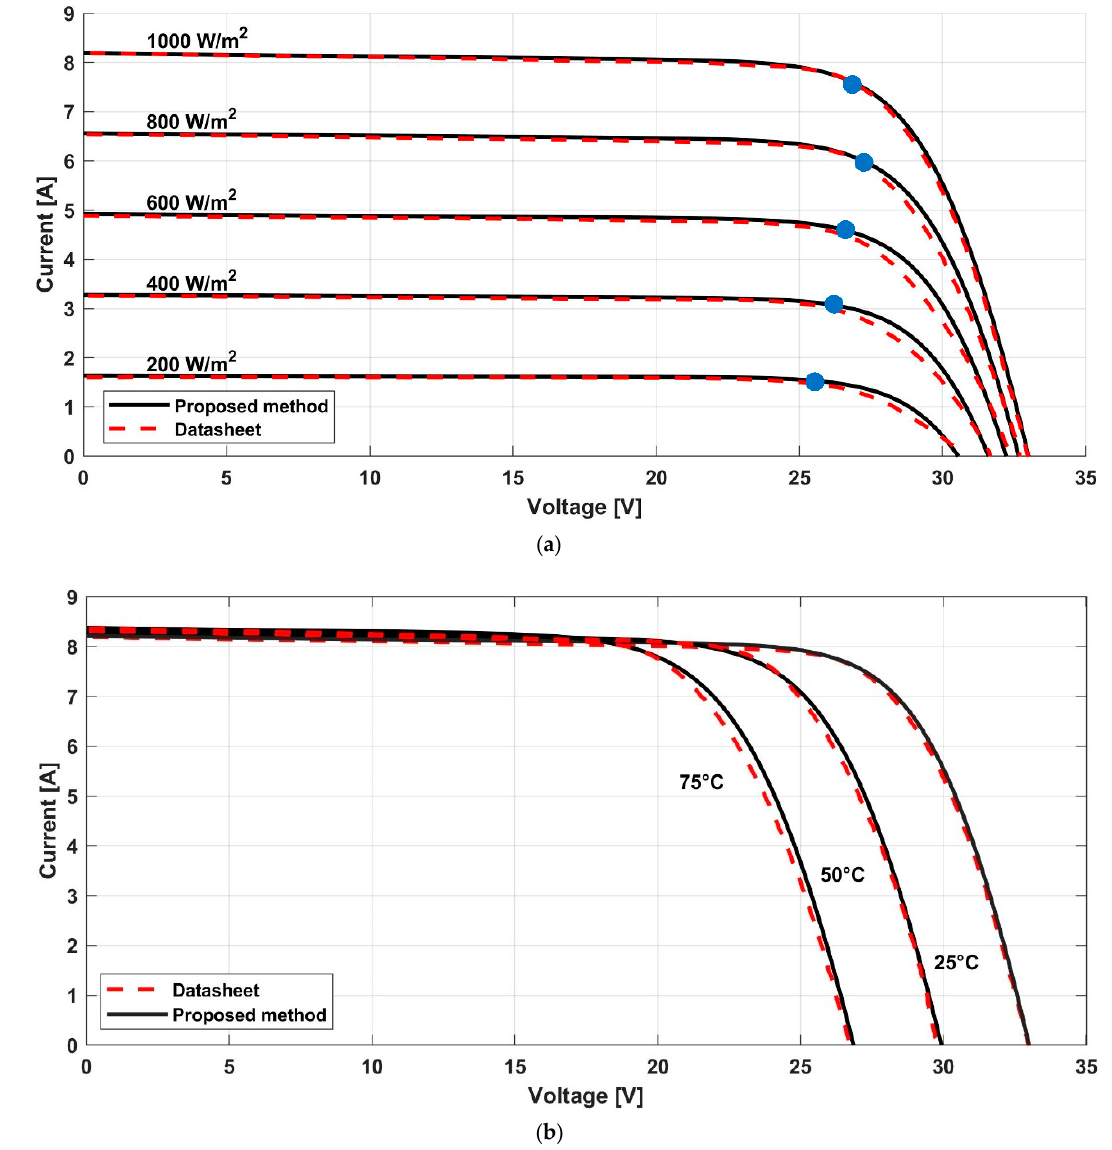
Figure 6. Comparison between the estimation and measured data of solar irradiance variation with circled MPP point ( a ) and temperature variation ( b ) of the proposed method.